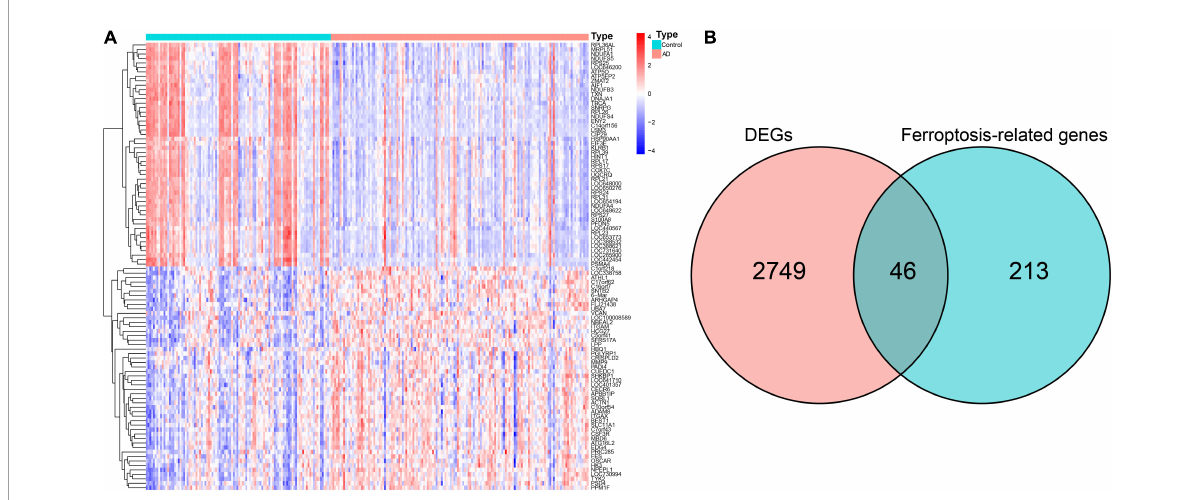
FIGURE2 Identification of hub ferroptosis-related genes. (A) Heatmap for the top 50 upregulated and downregulated DEGs. (B) Venn diagram showing candidate ferroptosis-related genes. DEGs, differentially expressed